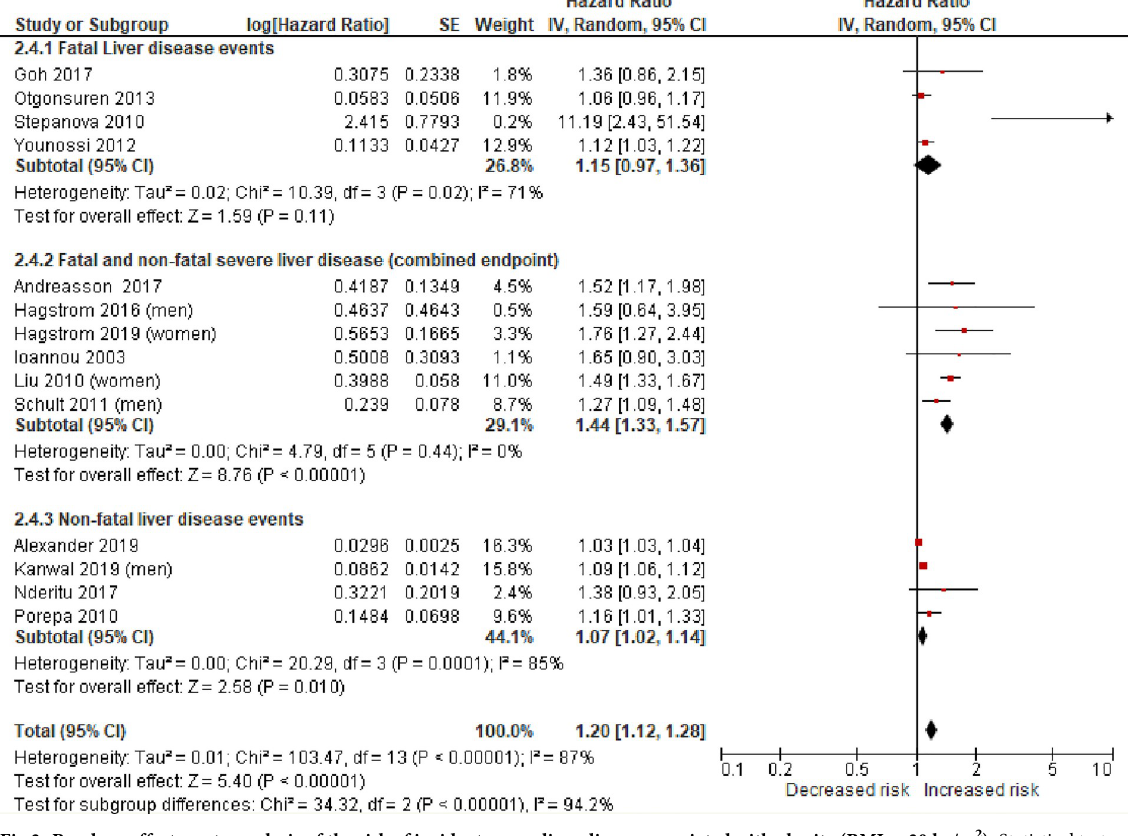
Fig 3. Random-effects meta-analysis of the risk of incident severe liver disease associated with obesity (BMI > 30 kg/m 2 ). Statistical test for study heterogeneity = chi-squared test. Statistical test for summary effect in the meta-analysis = Z test. IV, inverse variance.